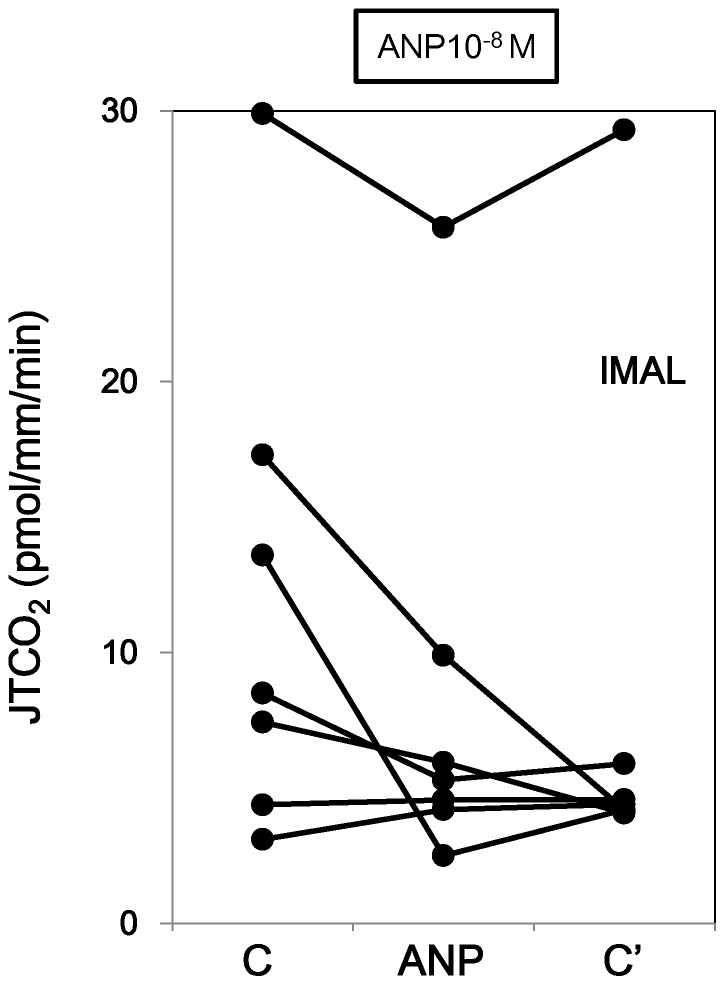
Effect of ANP on HCO3
− transport in lMALs in the absence of AVP.ANP at the concentration of 10−8 M did not cause changes in HCO3
− absorption in lMALs in the absence of AVP.